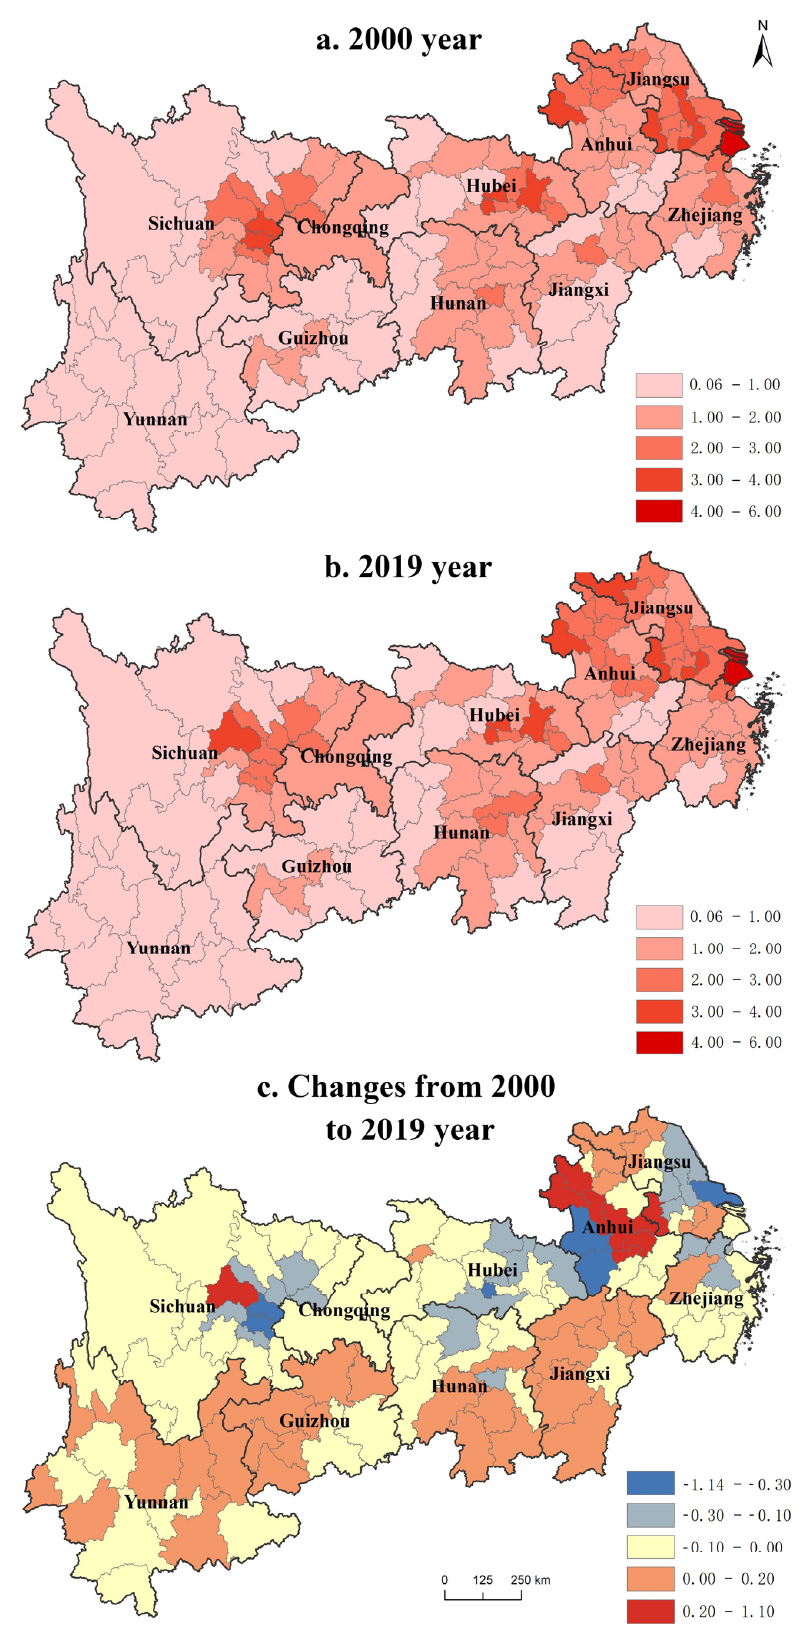
Figure 3. The evolution pattern of population geographic concentration from 2000 to 2019.